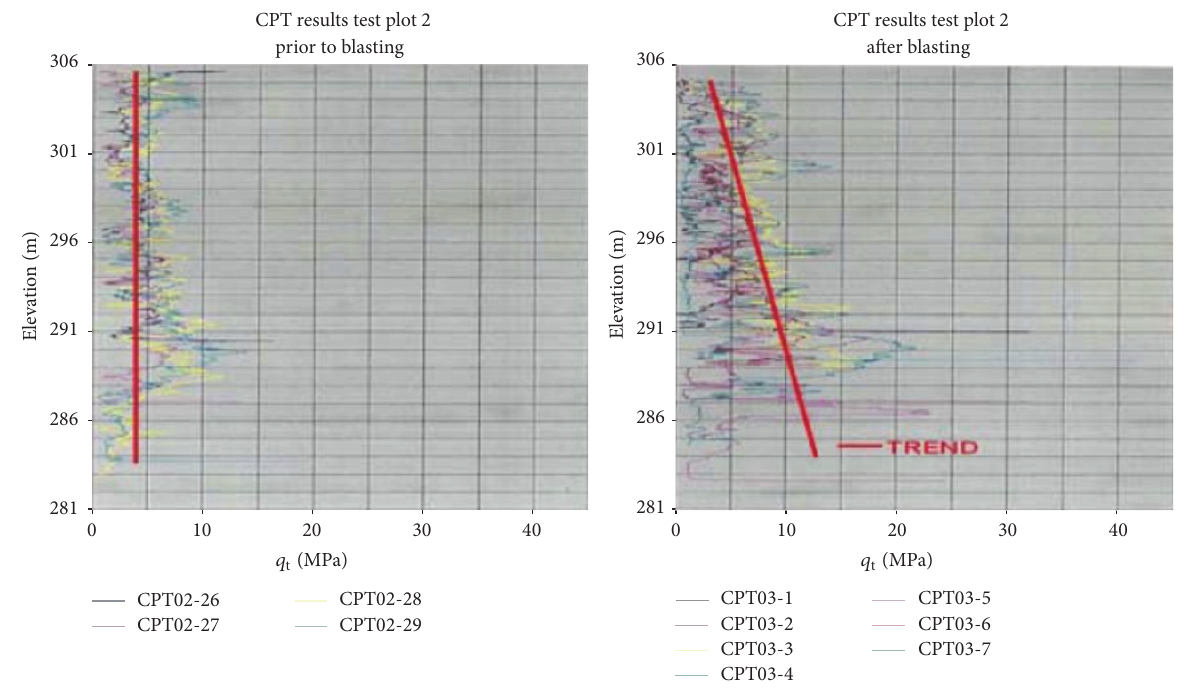
Figure 4: CPT results before and after EC in test site [21].